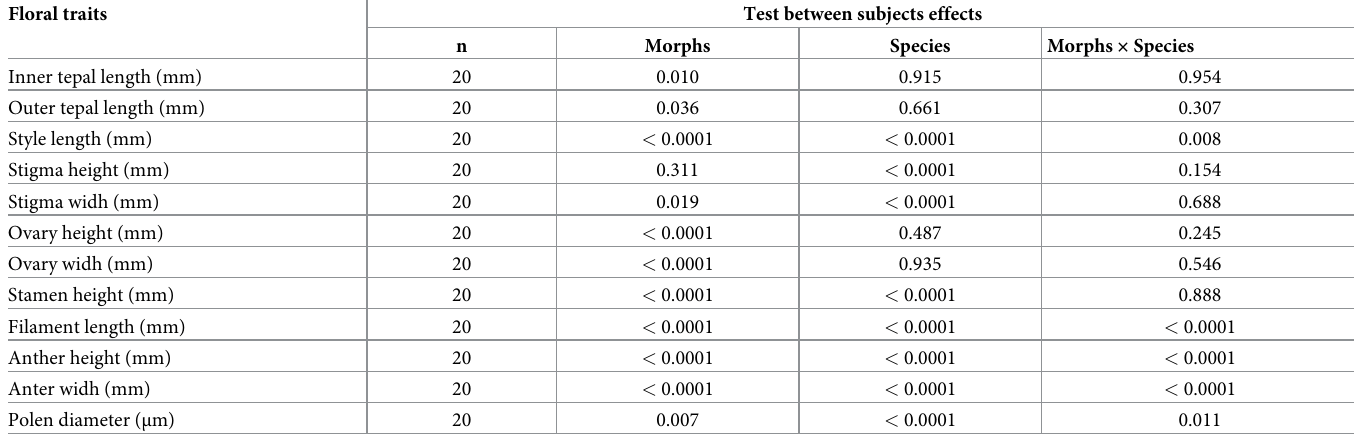
Table 2. P-values of the statistical analyses (ANOVA) related to floral morphology of P . equisetiforme var. graecum , P . equisetiforme var. peyerinhoffi , P . aviculare and P . maritimum . Floral